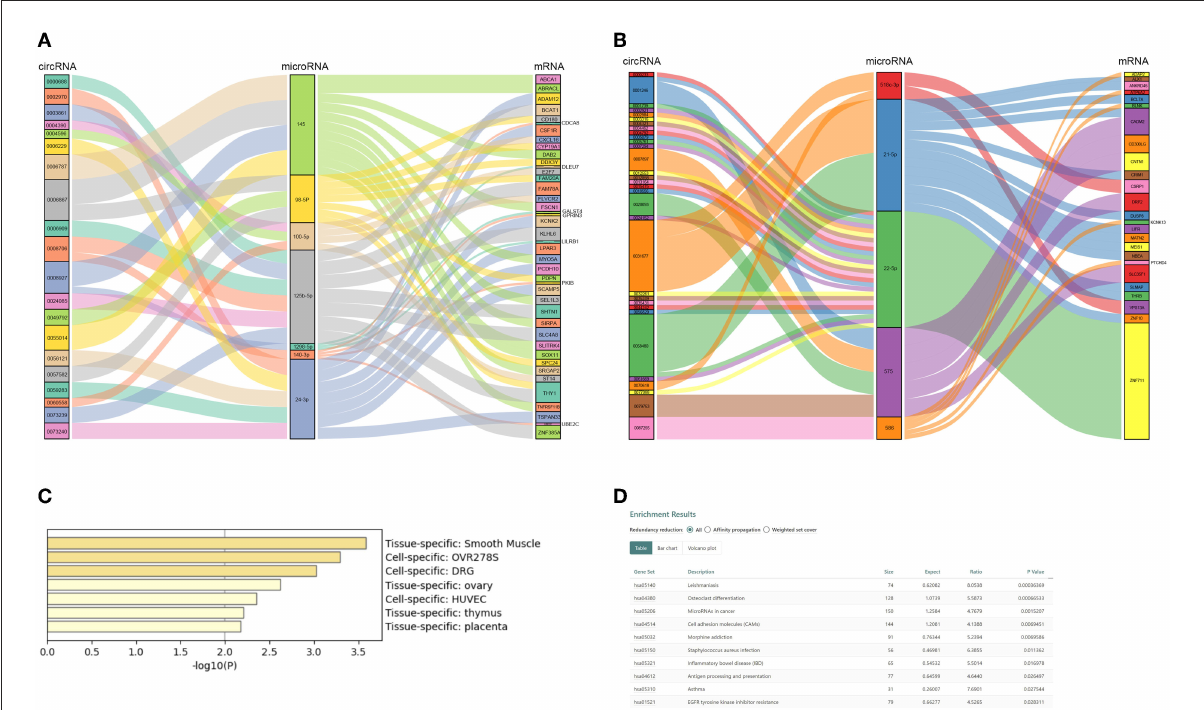
FIGURE4 Competing endogenous RNA (ceRNA) network of ASO-related circRNAs and mRNAs. (A) A Sanky plot of the ceRNA network in which microRNAs were downregulated in patients with ASO; (B) A Sanky plot of the ceRNA network in which microRNAs were upregulated in patients with ASO; (C) The tissue distribution result of mRNAs in the ceRNA networks; and (D) The pathway enrichment results of mRNAs in the ceRNA